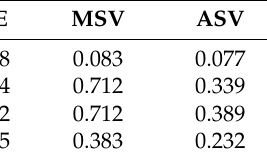
Table 1. Reliability report.